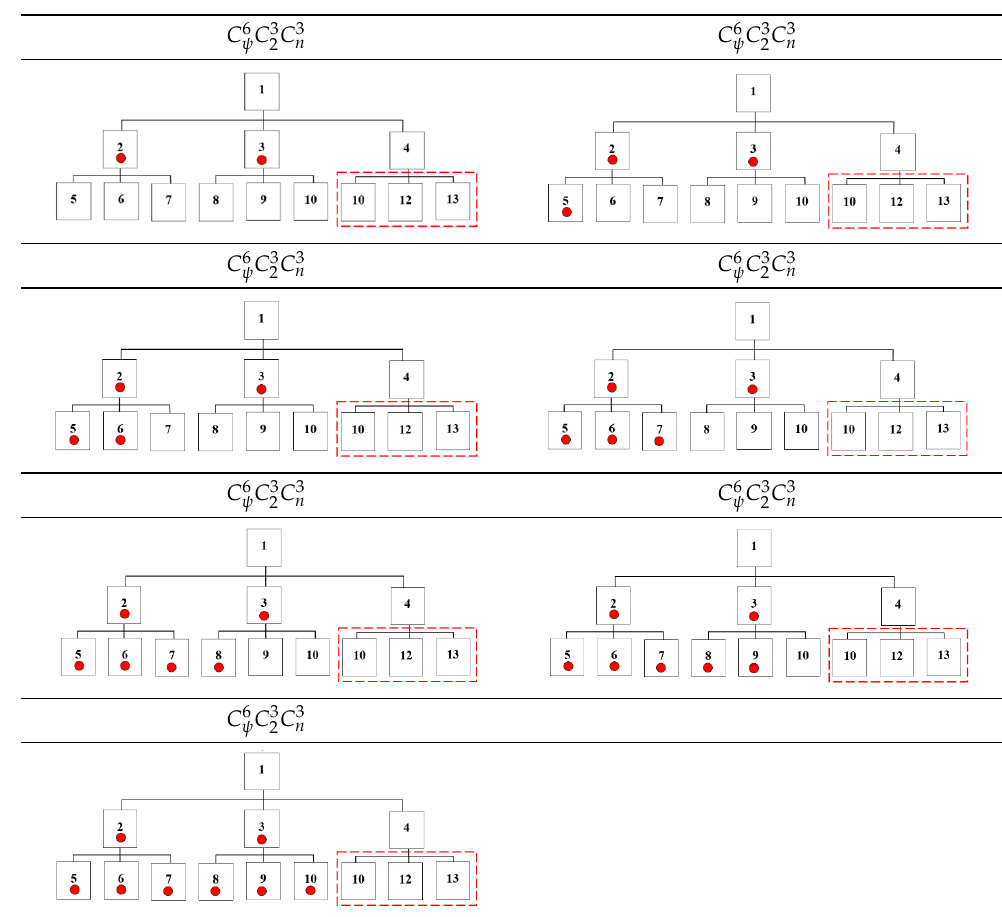
Table 2. Combinations of 2nd and 3rd levels for absorptions at 2 nodes of the 2nd